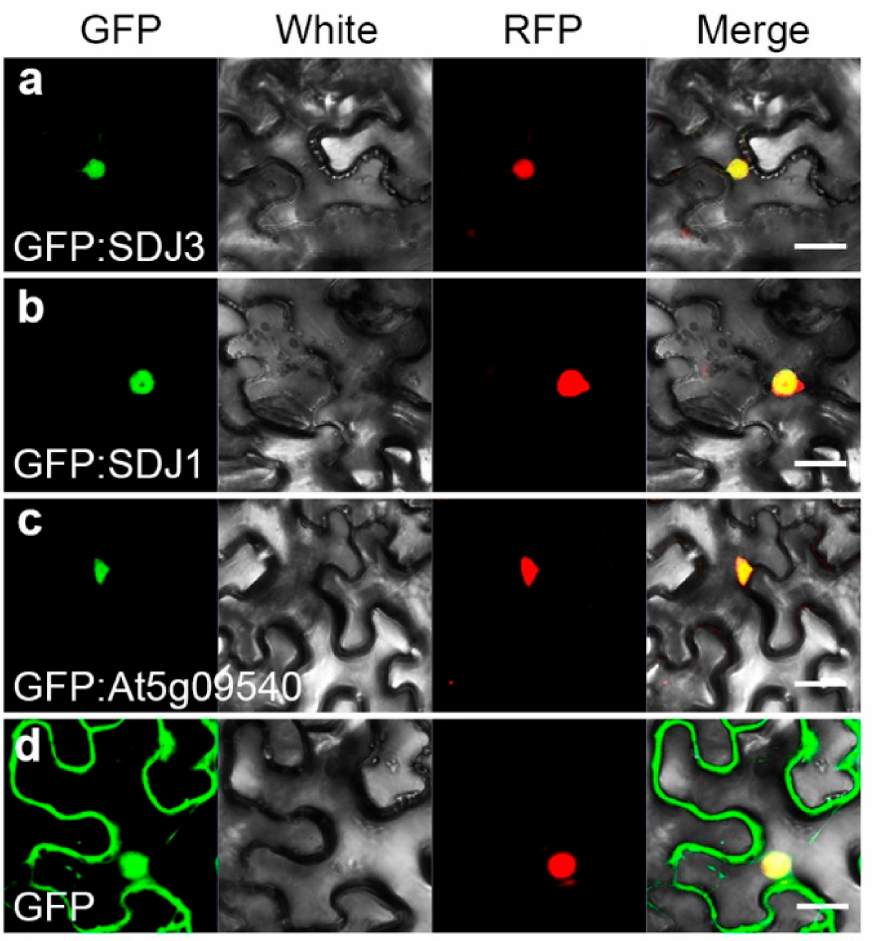
Figure 6. Localization of DnaJ proteins in nucleus. ( a – c ) The transiently expressed GFP:SDJ3, GFP:SDJ1, and GFP:At5g09540 proteins are colocalized with Coilin:RFP protein in nucleus in tobacco epidermal cells. ( d ) GFP protein is freely distributed in cytoplasm and nucleus. Scale bar = 25 µ